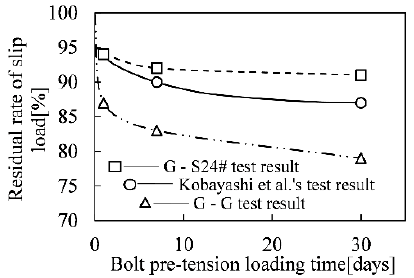
Figure 11. Comparison of the slip load residual rate after the bolt pre-tension relaxation tests.